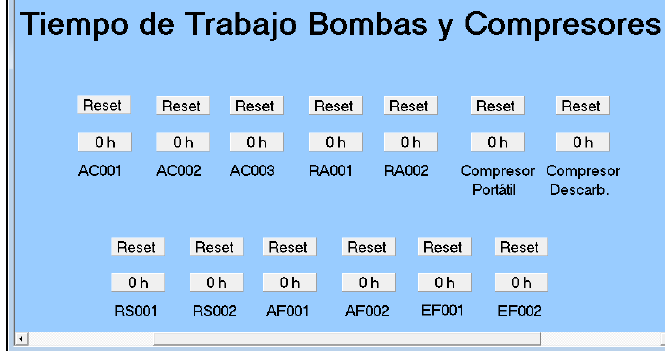
Figure 9: Pump and Compressor Work Time Interface.